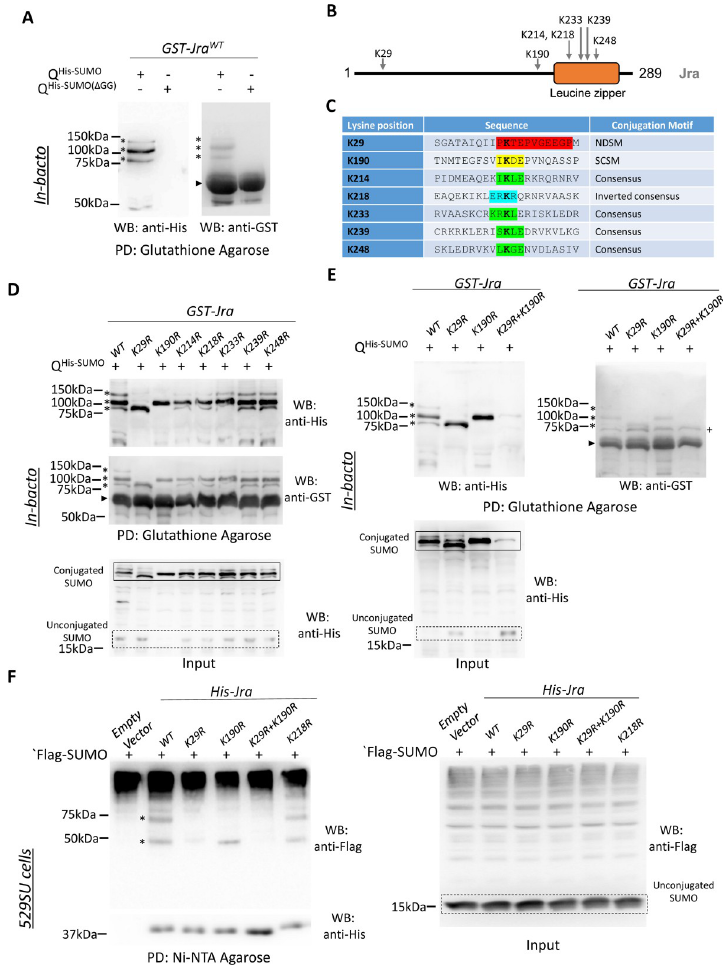
Fig 1. Site-directed lysine mutagenesis screen identifies Jra(K29) and Jra(K190) as acceptor sites for SUMOylation,. A. Anti-His western blot (left panel) post Glutathione agarose affinity pulldown (PD) shows three SUMOylated bands for GST-Jra (marked by asterisks, � ). GST-Jra WT co-transformed with immature SUMO (SUMO- Δ GG) serves as a negative control for SUMO conjugation. Anti-GST WB (right panel) post affinity PD indicates similar levels of GST-Jra WT . The SUMO conjugated species of Jra are seen as three faint bands (marked by asterisks) above unconjugated Jra (marked by an arrowhead). B. Schematic of the primary sequence of Drosophila Jra. The conjugation sites to be tested (panel C) are mapped onto Jra. Secondary structure prediction indicates that the Jra N- terminus is unstructured (black line), while the C-terminus (residues 210–275) is helical. This agrees with structures deposited in the Protein Data Bank (PDB:1FOS), which correspond only to the C-terminal leucine zipper (orange box), formed from c-Jun/c-Fos dimers. C. Putative SUMO motifs predicted for Jra include the negative amino-acid dependant SUMO motif (NDSM; K29), synergy consensus SUMO motif (SCSM; K190), four consensus SUMO motifs (K214, K233, K239 and K248) and an inverted consensus motif (K218). D. Anti-His western blot (upper panel) post PD shows the SUMOylated bands of Jra and its mutant variants depicted by asterisks. Jra K29R shows partial loss of SUMOylation where the two bands on the top disappear. Also, Jra K190R shows partial loss of SUMOylation where the upper and lowermost SUMOylated bands disappear. Anti-GST western blot (middle panel) post PD showing different variants of unconjugated GST-Jra (marked by an arrowhead) along with GST-Jra conjugated with SUMO (marked by asterisks). Anti-His WB of the lysates prior to pulldown in the lower panel shows the conjugated and unconjugated SUMO protein. E. Anti-His western blot (top left panel) of Jra post PD showing the three distinct SUMOylated Jra bands in Jra WT . Partial loss of SUMOylation in Jra K29R and Jra K190R, as seen in panels D is confirmed. Jra K29R+K190R shows complete loss of SUMOylation. Anti-GST western blot (top right panel) post PD showing unmodified Jra (marked by an arrowhead) along with modified Jra (marked by asterisks). Anti-His WB of the lysates prior to pulldown in the lower left panel shows the conjugated and unconjugated SUMO protein. F. In-vivo demonstration of SUMOylation of Jra. Anti-Flag western blot post-Ni-NTA affinity pull-down in the upper left panel represents the SUMOylated species of Jra seen as two distinct bands, marked by asterisks. Jra K190R shows loss of the upper band, indicating partial loss of SUMOylation. Jra K29R and Jra K29R+K190R show complete loss of SUMOylation. Jra K218R